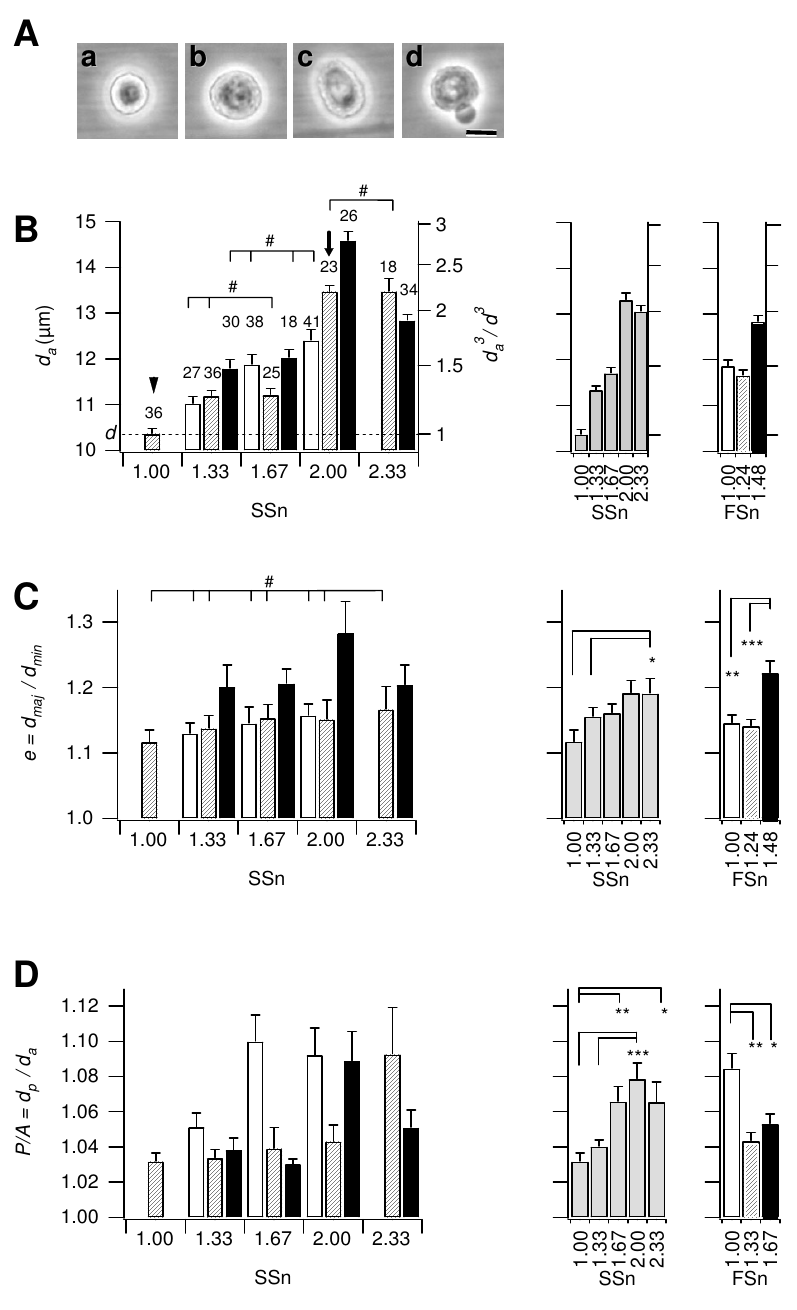
Figure 5 Cell size and shape of the sorted cells in the twelve subfractions . A: Phase-contrast micrographs of the sorted cells: spherical and small ( a ); spherical and large ( b ); oval ( c ); irregular surface ( d ). B-D: The diameter ( d surface roughness ( P/A , D ) of the cells are shown. These values were evaluated from the phase-contrast images of cells (see Methods). Left, average for each subfraction; middle, average for SSn ; right, average for FSn . Shading corresponds to that in Fig. 4C. The number of measured cells is shown on each column in B . The right ordinate of B is the relative cell volume ( d where d is the average of d at ( SSn , FSn ) = (1.00, 1.24) (arrow head). The relative cell volume at ( SSn , FSn ) = (2.00, 1.24) a (arrow) was about two. Statistically significant for C and D at * P < 0.05; ** P < 0.005; *** P < 0.0005. Statistically not significant for B and C at # P >